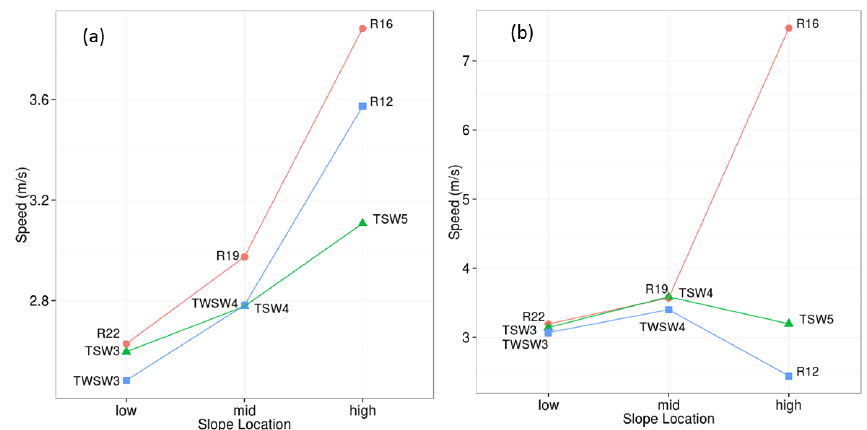
Figure 7. Average wind speeds for sensors at three slope locations (low, mid, and high) along three transects during the (a) upslope (11:00 LT) and (b) downslope (00:00 LT) flow regimes at Big Southern Butte.